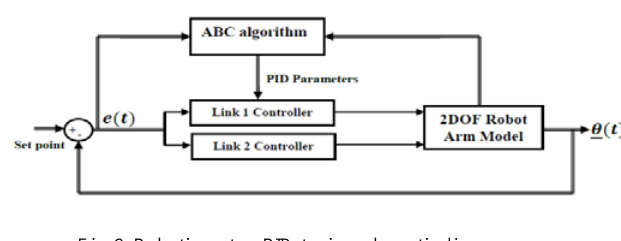
Table I provides the optimal controller parameters and the corresponding values of objective functions with three different objective functions. The simulation results and the performance of the robotic